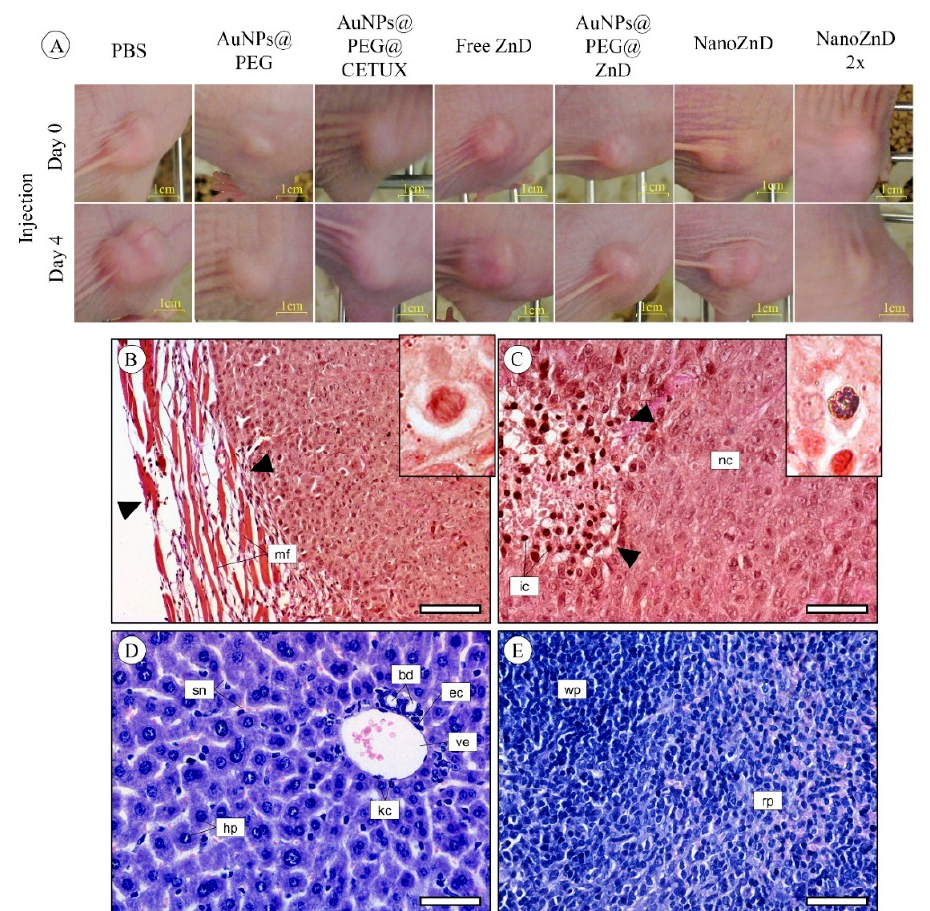
Figure 8. ( A ) Images of mice tumor xenografts on the day of injection of each formulation and four days later. Example of micrographs of representative histological sections of tumor, liver, and spleen from tested mice. ( B ) Mixed tumor border configuration, showing part of the fibrous encapsulation (between arrowheads), formed by connective tissue and muscle fibers (mf). Inset: Detail of a mitosis in tumor cells. ( C ) Tumor presenting a compact mass of neoplastic cells (nc) and foci of infiltrating inflammatory cells (ic), within which are found debris of necrotic cells (arrowheads). Inset: Detail of a small metallic agglomerate inside a macrophage found in a tumor from a mouse injected with gold nanoparticles. ( D ) Representative micrograph of the hepatic tissue of mice, showing the normal architecture of the organ, i.e., with regular-sized hepatocytes (hp) arranged in trabeculae. bd: bile duct, ec: endothelial nucleus cell, kc: Kupffer cells, sn: sinusoids, ve: venule. ( E ) Representative micrograph of the spleen of tested mice. Regardless of experimental treatment, no histopathological alterations were found in the organ. rp: red pulp, wp: white pulp. ( B ) and ( C ), tetrachrome (TC) stain. ( D ) and ( E ), Gill’s Alum Hematoxylin and counterstained with alcoholic Eosin Y (H&E), Insets, neutral red. Scale bars: ( B ): 100 µ m, ( C – E ): 50 µ